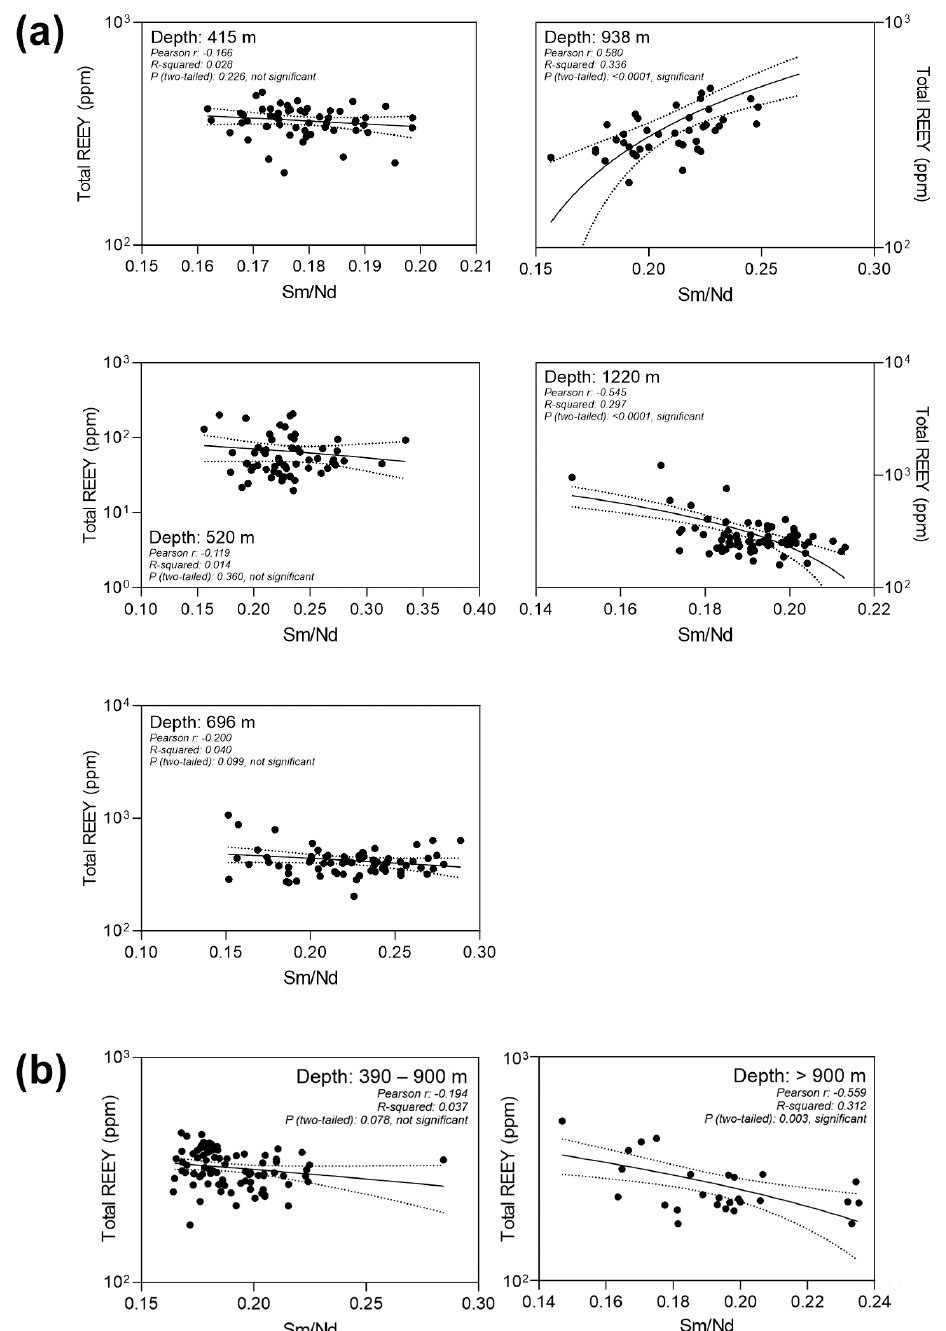
Figure 7. Statistical relationships between alteration proxies obtained from this study through laser ablation analysis (a) and whole-rock geochemical data (b) compiled from Cox et al.